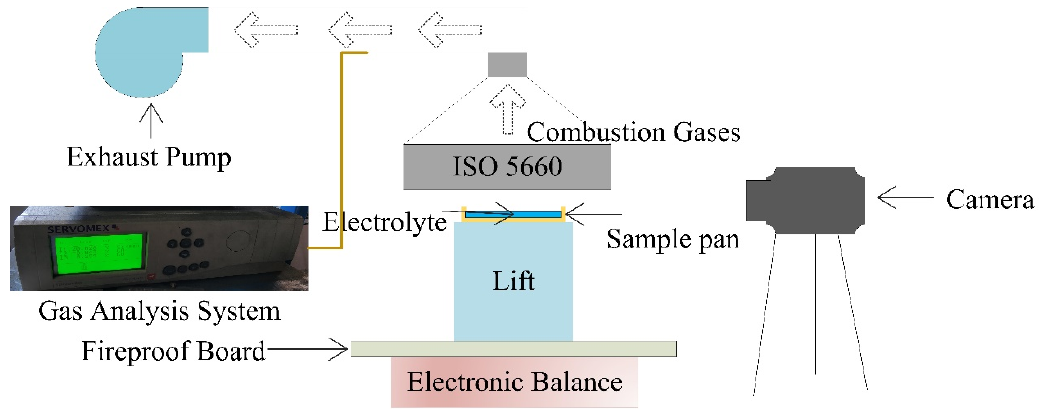
Figure 1. Structure diagram of cone calorimeter.